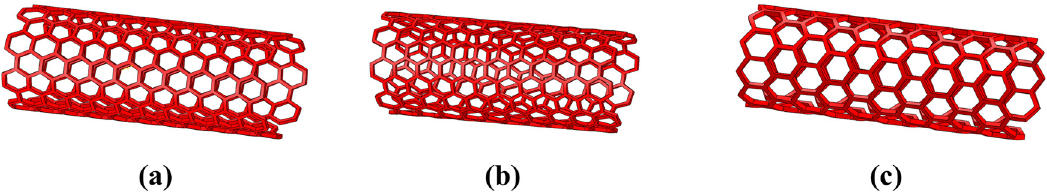
Figure 1: Schematical presentation of SWCNTs [ 19 ] . ( a ) Armchair, ( b ) chiral, ( c )